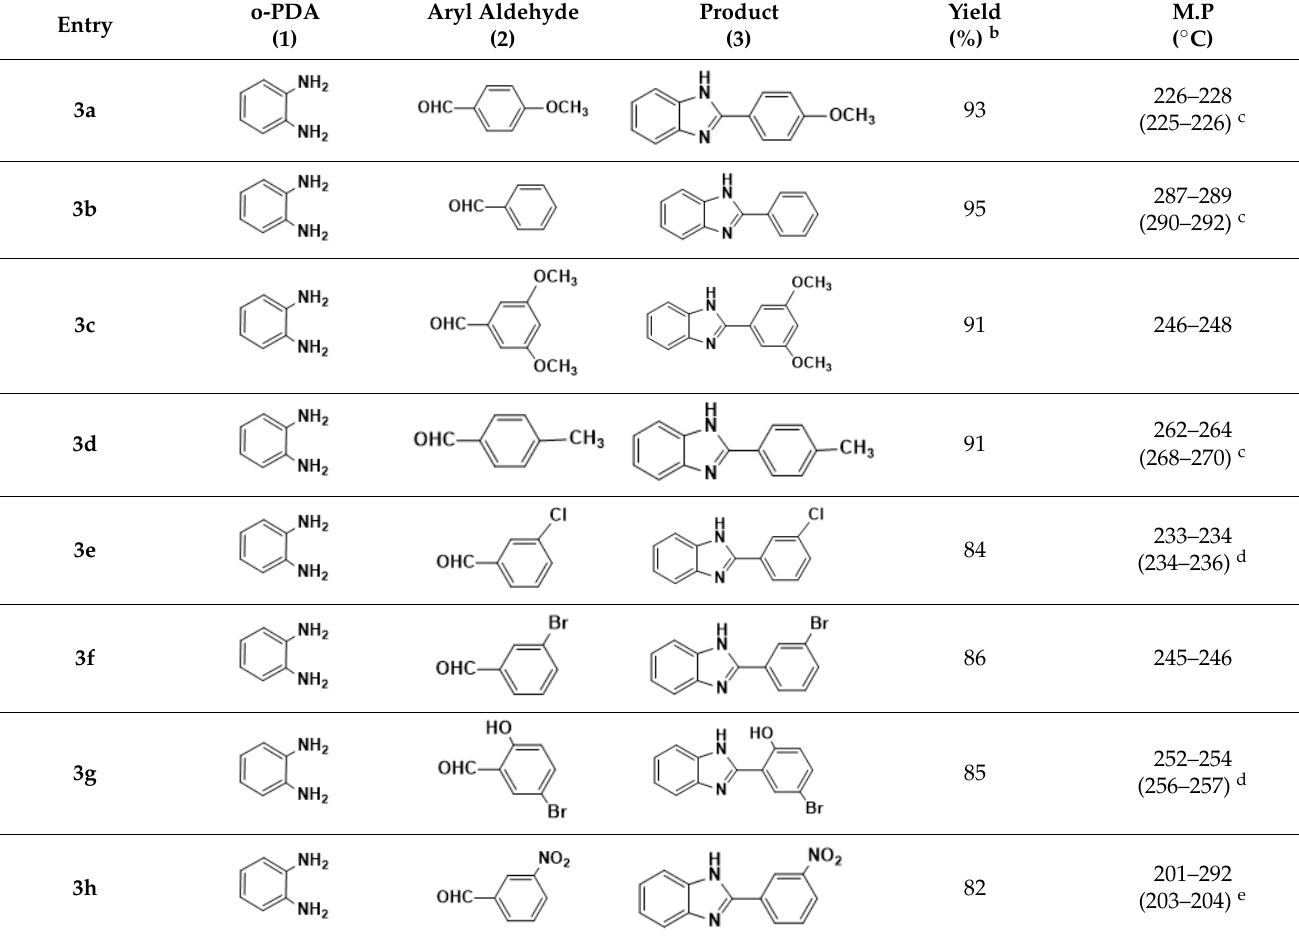
Table 4. Nano ZrO 2 catalysed synthysis of 2-aryl benzimidazoles a .